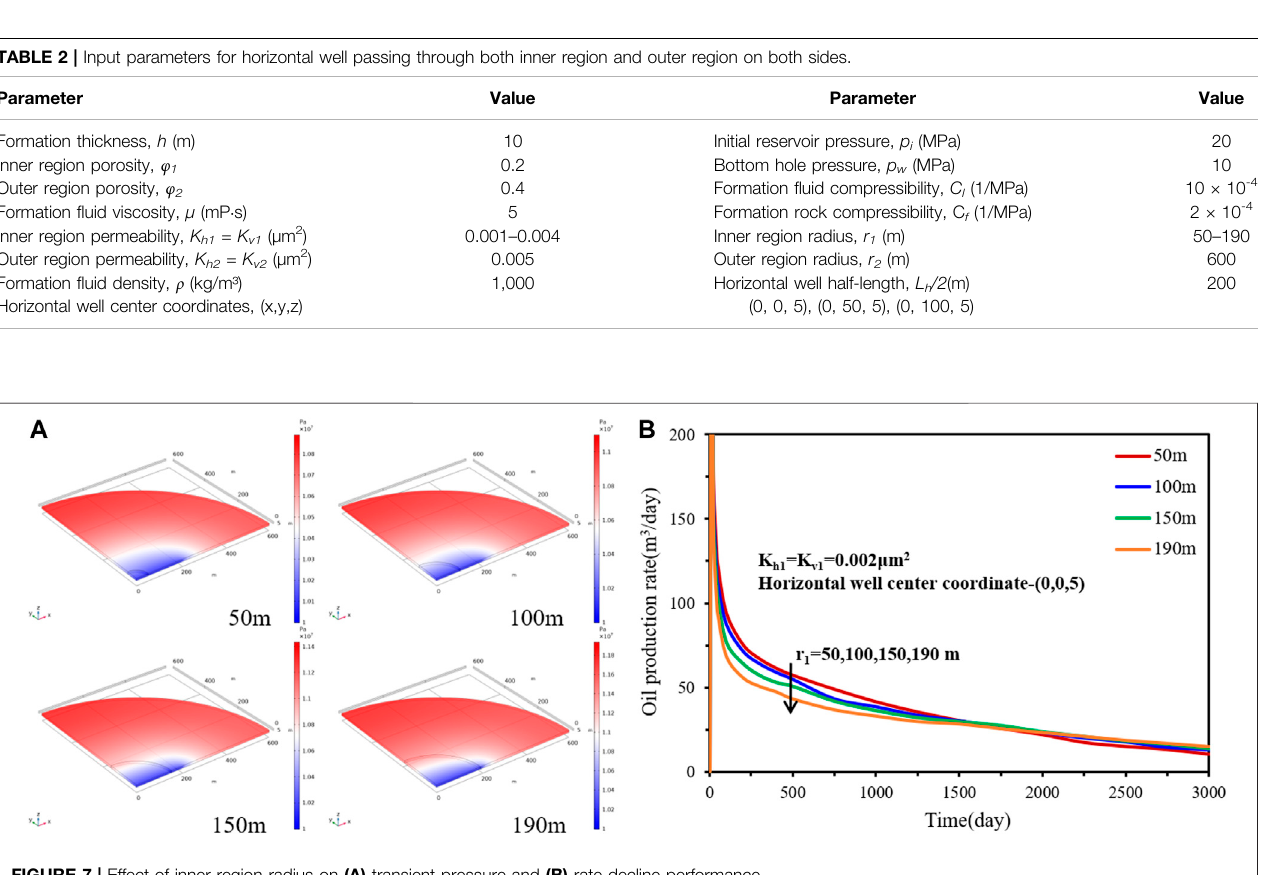
Frontiers in Energy Research |